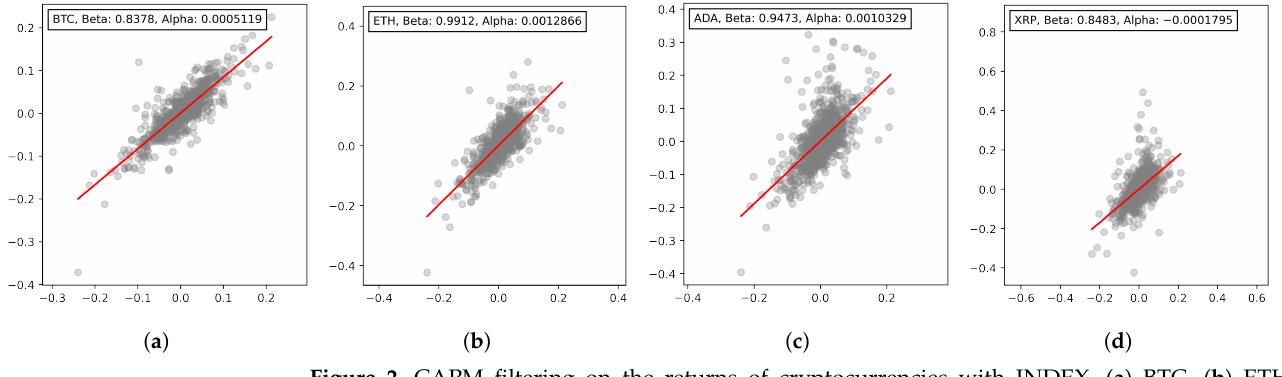
Figure 2. CAPM filtering on the returns of cryptocurrencies with INDEX. ( a ) BTC. ( b ) ETH. ( c ) ADA. ( d ) XRP.